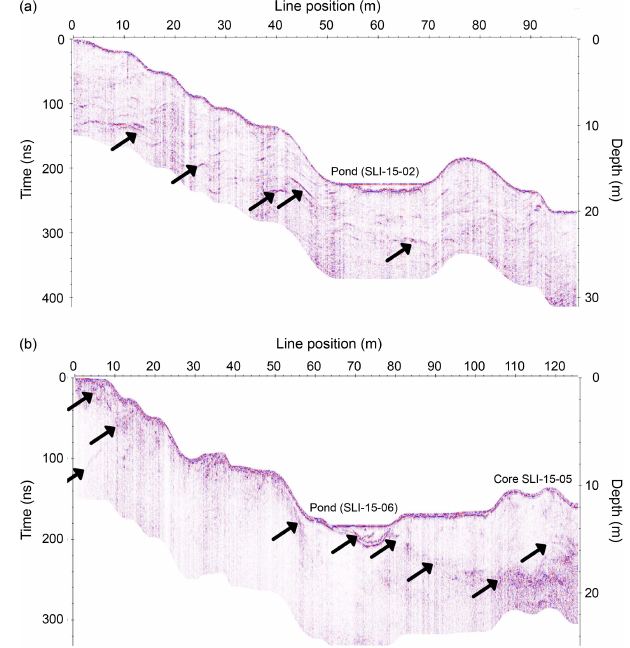
Figure 11. Processed 400MHz ground-penetrating radar data from the transect down the rock glacier. (a) Mid-rock glacier line show- ing interpreted internal debris and a mid-rock glacier pond ( ∼ 50– 70m; site of ice core samples SLI-15-02 and SLI-15-03). (b) Part of the transect crossing the frozen pond (sample sites SLI-15-06 and SLI-15-07) near the lowest buried ice core site (at 110m; SLI-15- 05). Arrows point to reflection events interpreted to correlate with internal debris